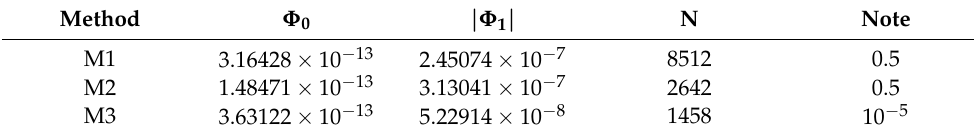
Table 2. Quantitative indicators of calculations for methods M1, M2 and M3.